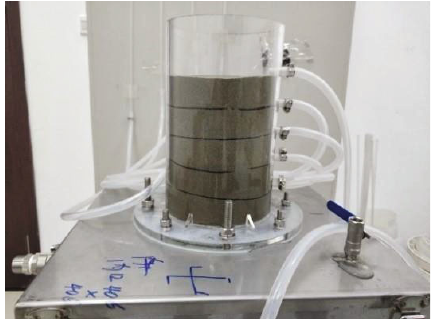
Figure 4: Tailing sand sample during the seepage failure.